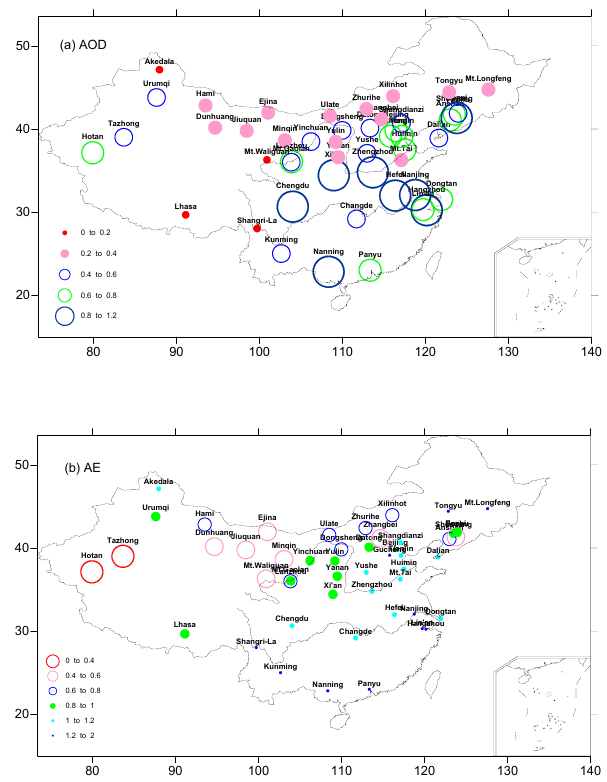
Figure 2. Spatial distributions of (a) AOD at 440nm and (b) AE between 440 and 870nm based on CARSNET